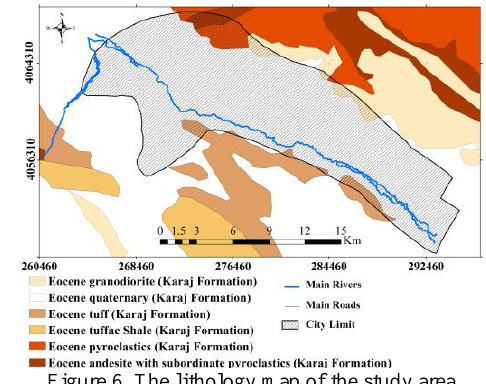
Figure 6. The lithology map of the study area